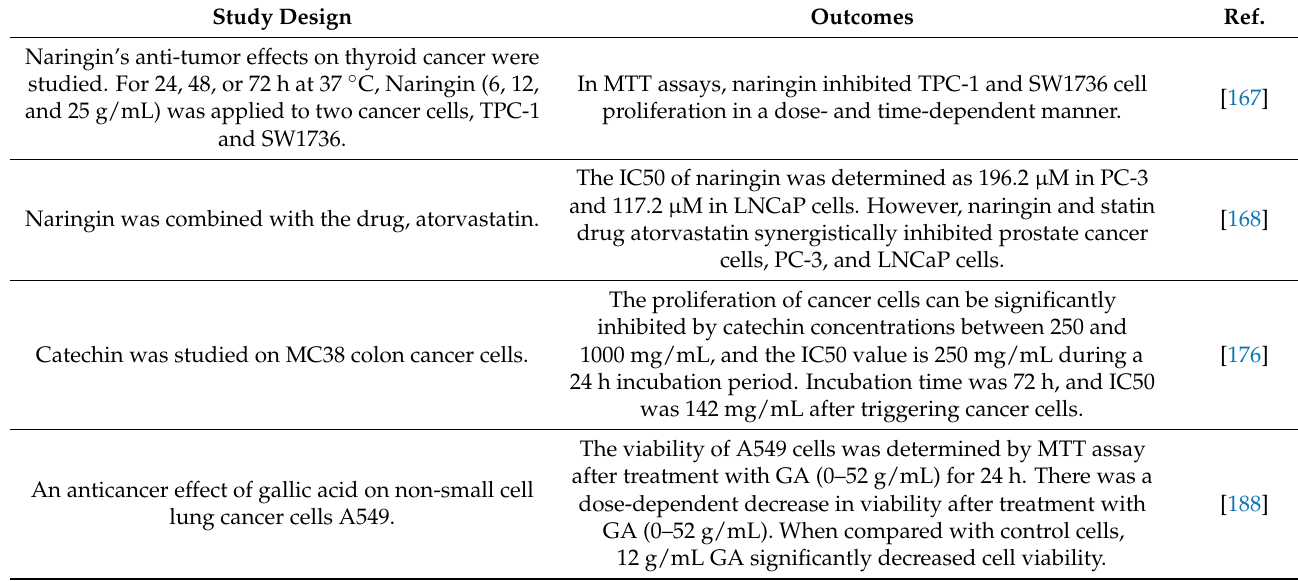
Table 4. Some of the information regarding polyphenols efficacies, working concentration, and target of each substance on DNA and